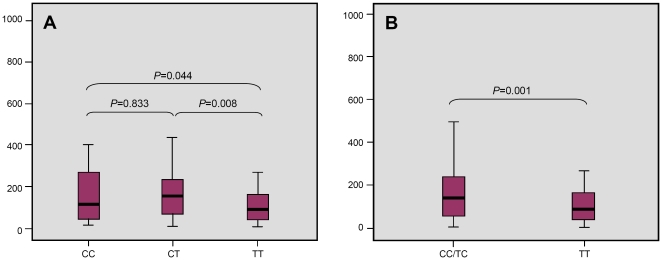
Numbers of MLs (e6/L) in CSF in different CCL2 tag SNP rs4586 genotype groups in TBM patients.(A) Comparison of homo- and heterozygotes. (B) Testing dominant model for common allele C.